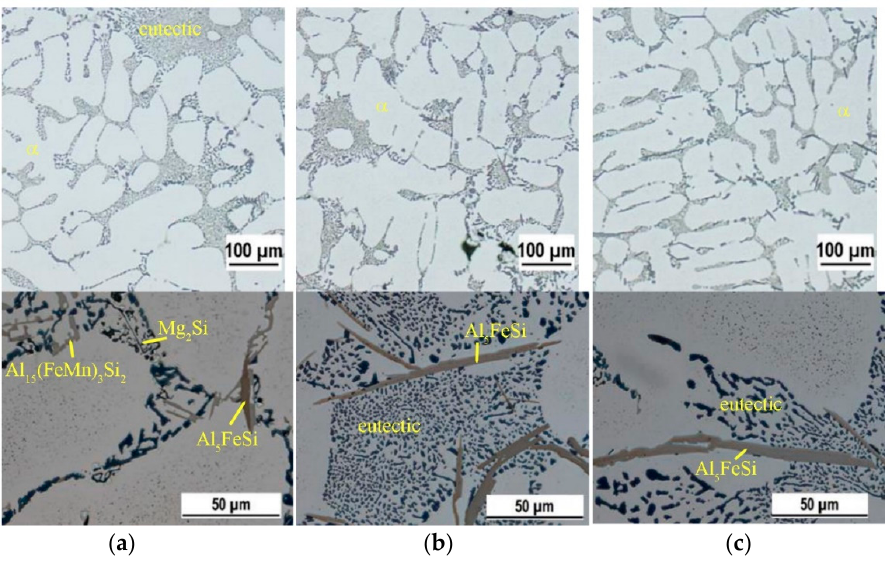
Figure 2. Microstructure of AlSi7Mg0.3 cast alloys, etch. MA. ( a ) alloy A with 0.123 wt. % Fe; ( b ) alloy B with 0.454 wt. % Fe; ( c ) alloy C with 0.655 wt. % Fe.